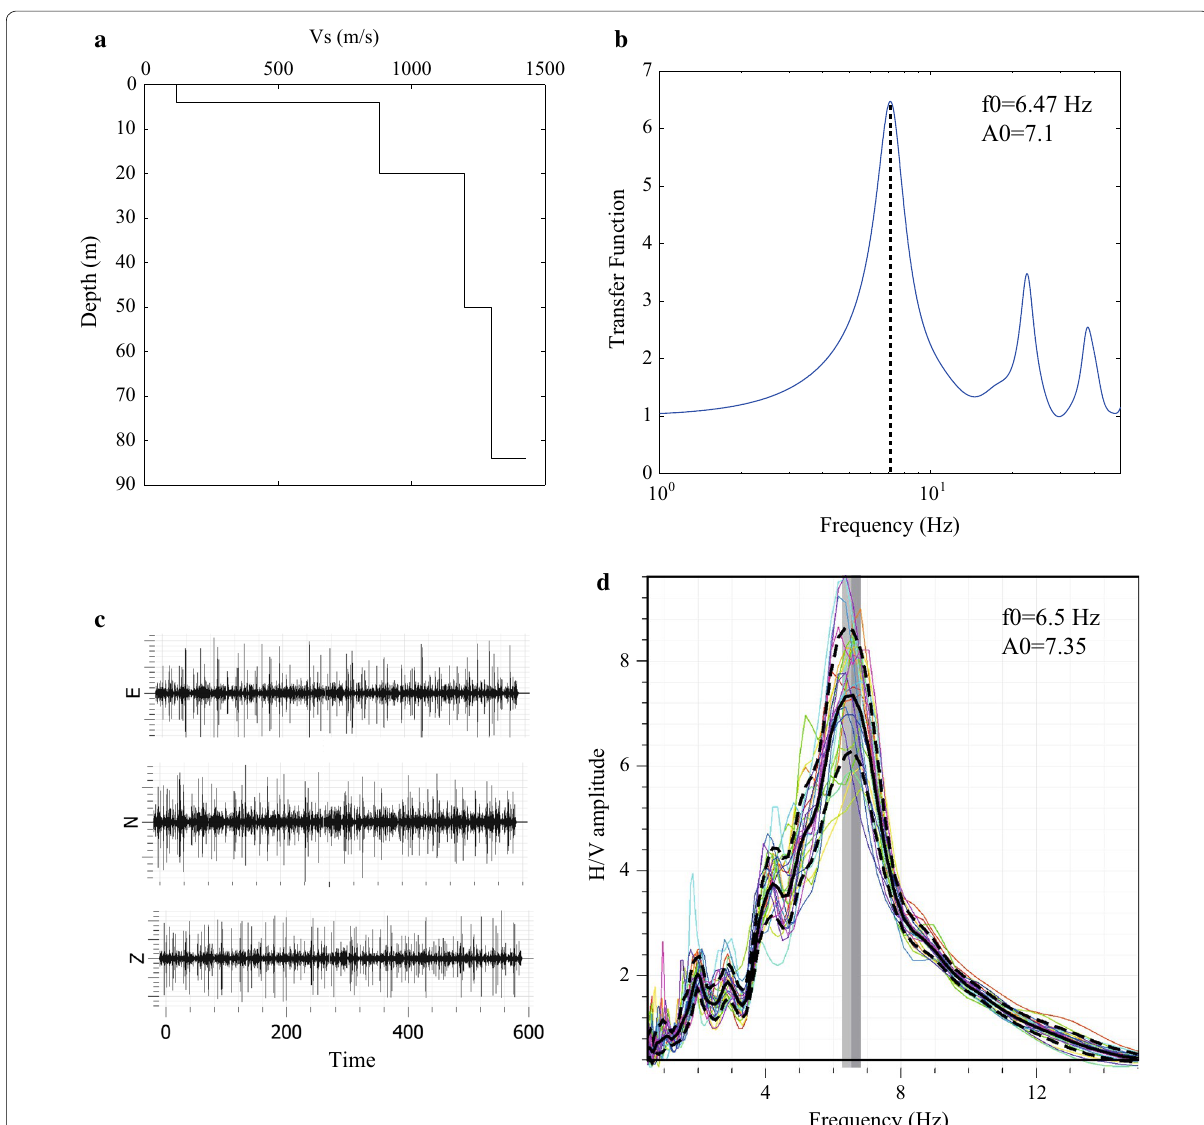
Fig. 6 Example of seismic noise simulation results for a soil profile (ABSH02 from KIK‑net database): a shear wave velocity profile of the soil, b S wave transfer function using transmission/reflection method, c example noise synthetics along the 3 components (East, North, Vertical), d H / V curve from synthetic